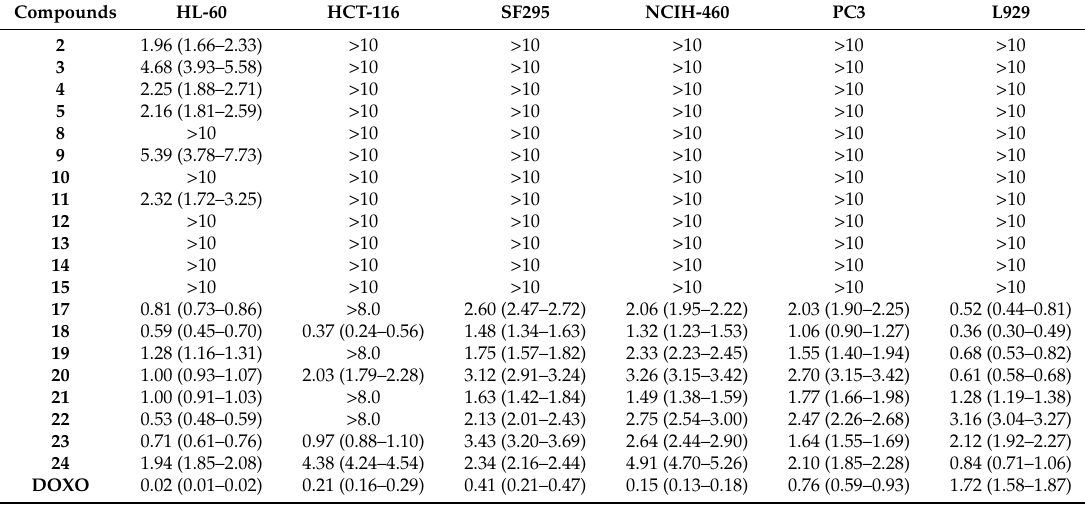
Table 1. Cytotoxic activity expressed by IC 50 µ M (95% CI) of compounds in cancer and normal cell lines after 72 h exposure, obtained by nonlinear regression for all cell lines from three independent